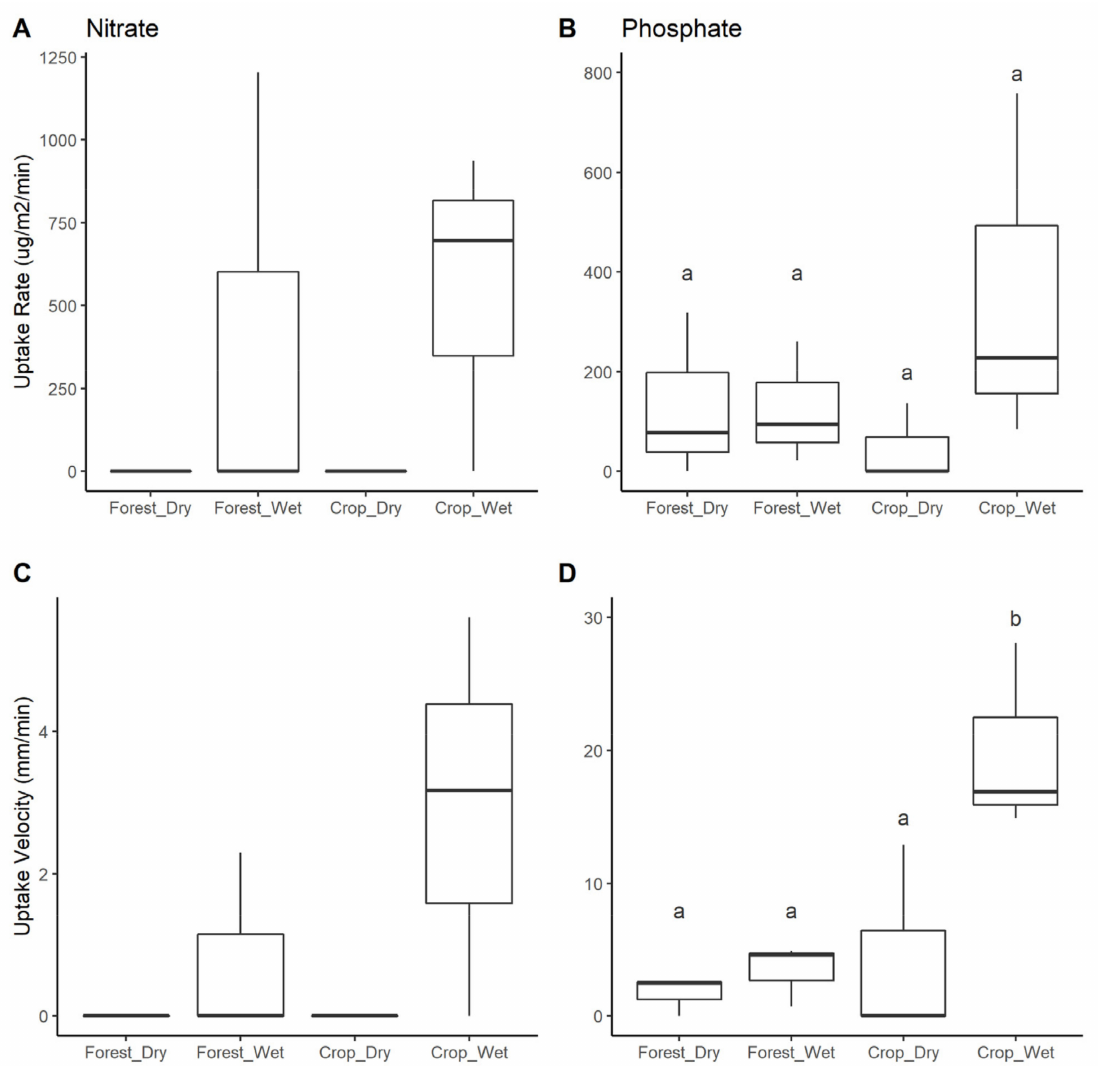
Figure 6. Median and variation in stream nutrient uptake rate and velocity by land use and season: ( A ) Nitrate uptake rate, ( B ) Phosphate uptake rate, ( C ) Nitrate uptake velocity, and ( D ) Phosphate uptake velocity. Significant differences at p < 0.05 are indicated by distinct letters above the boxes. Format of boxplots is as follows: horizontal line indicates the median value, box shows the inter-quartile range, and whiskers extend to 1.5 times the inter-quartile